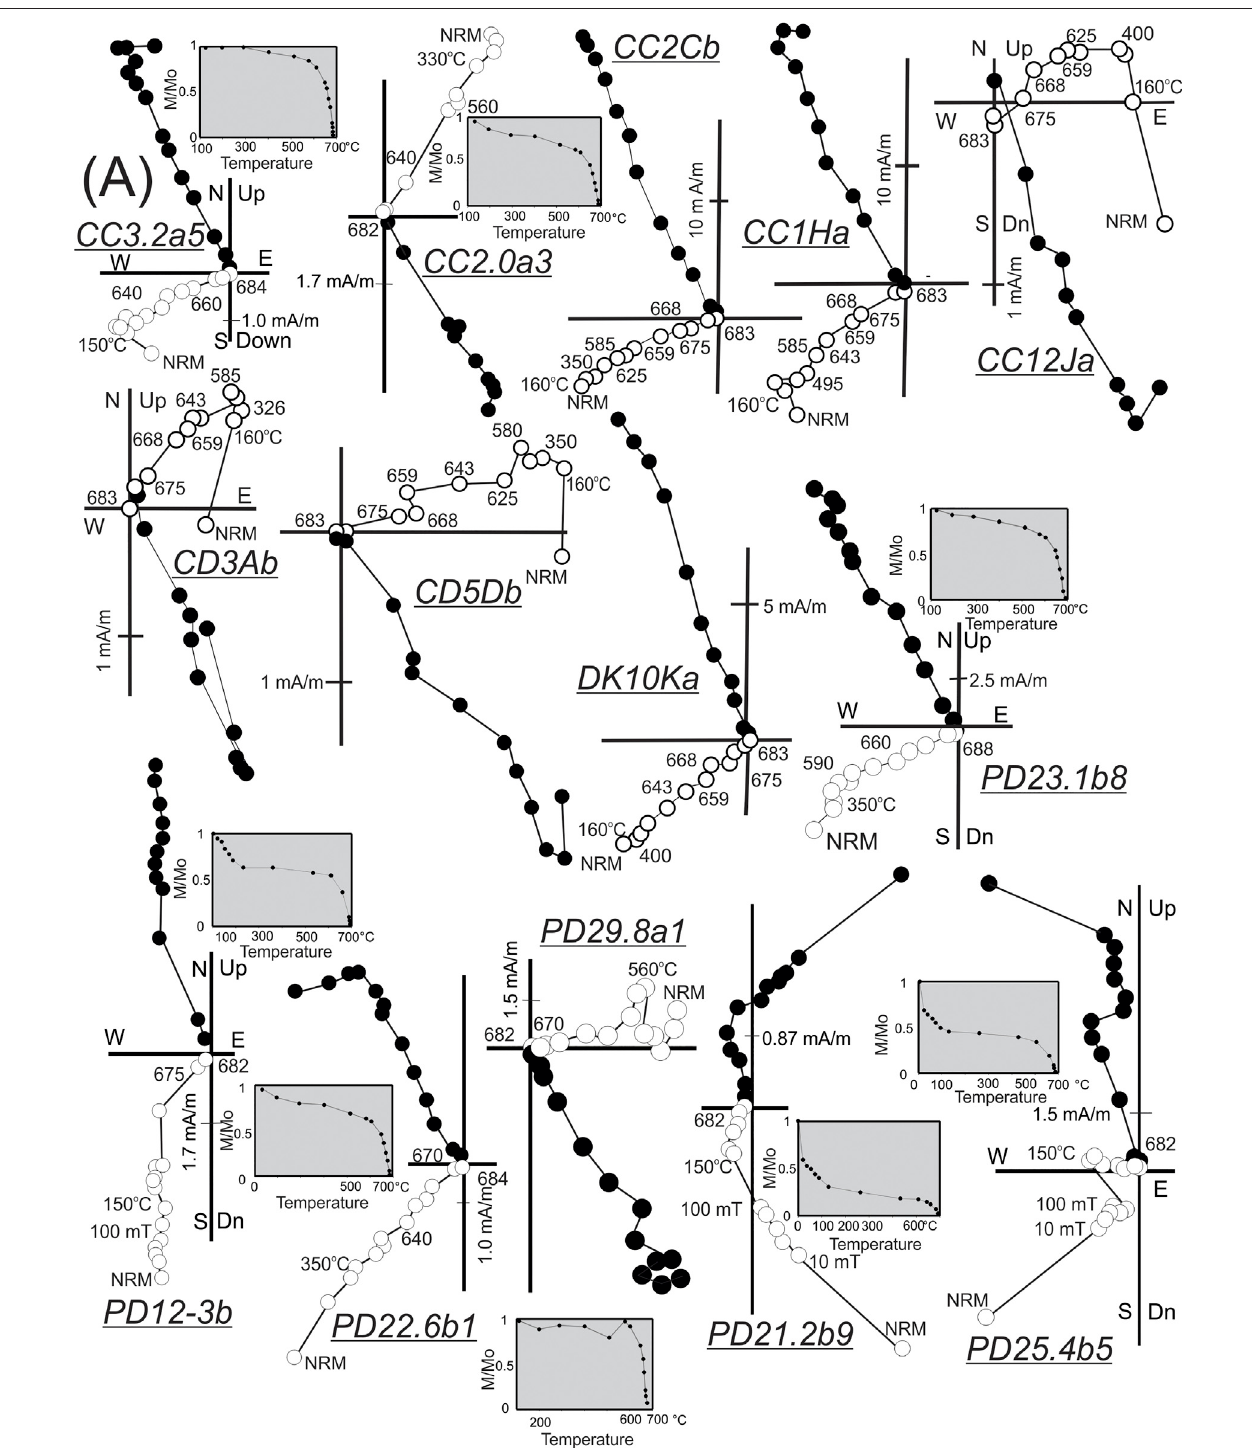
FIGURE 7 | Orthogonal progressive demagnetization diagrams (Zijderveld, 1967) showing the end point of the magnetization vector plotted onto the horizontal ( fi lled symbols) and vertical (open symbols) planes (NS-EW, EW-Up/Dn) for individual specimens from samples from selected sites at some of the northwest Texas sections sampled for this study. Specimens have been subjected to either progressive thermal demagnetization or a combination of alternating fi eld and then thermal demagnetization. Selected demagnetization steps are shown for data points in the vertical projection. In some cases, normalized intensity decay plots show response to progressive demagnetization. CC, Caprock Canyons; PD, Palo Duro Canyon; D, Dickens; CD, Clarendon. Additional details are in Supplemental Information .